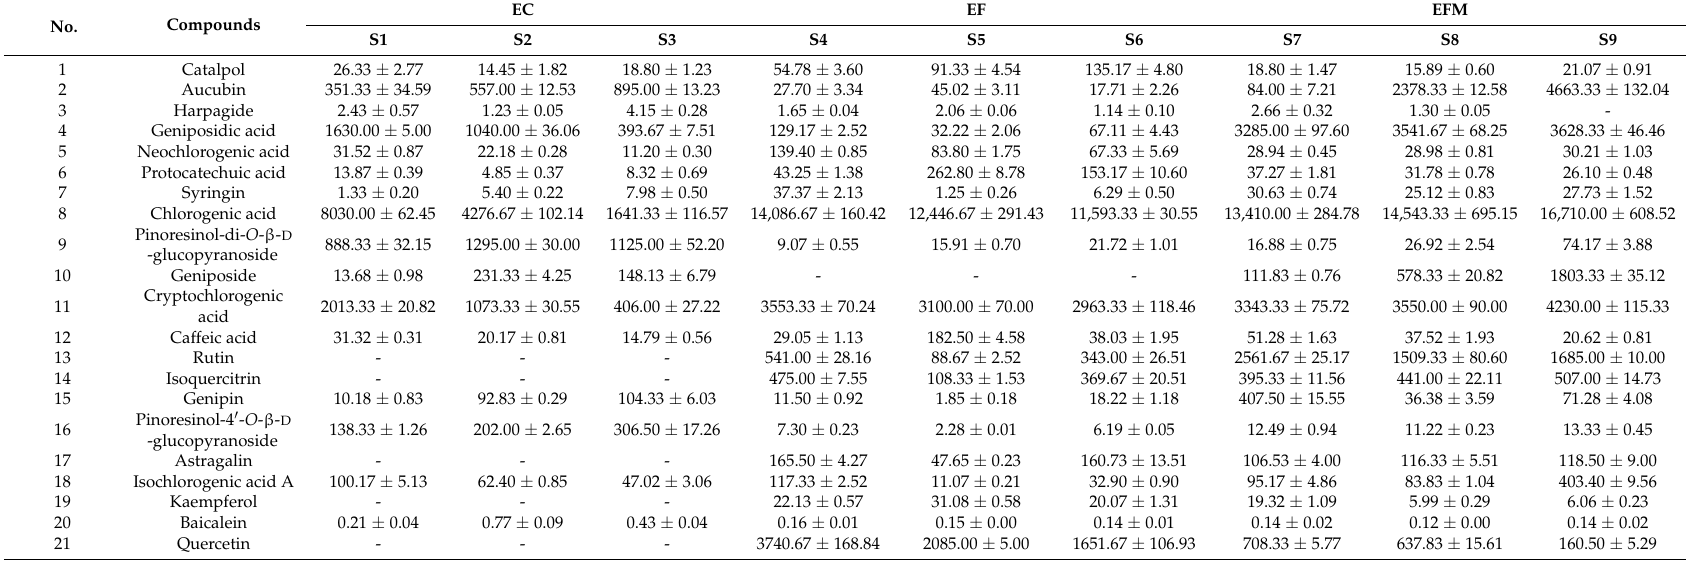
Table 3. Contents of 21 compounds in EC, EF, and EFM ( µ g/g, mean ± SD, n =